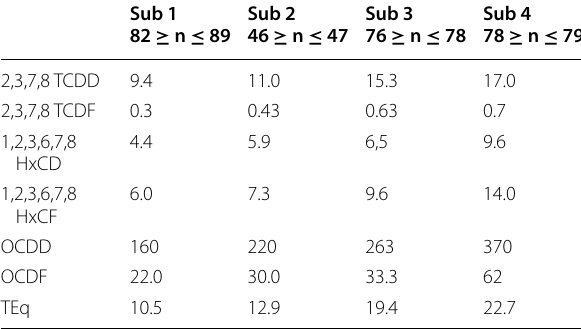
Table 2 Median comparison of selected congeners within-